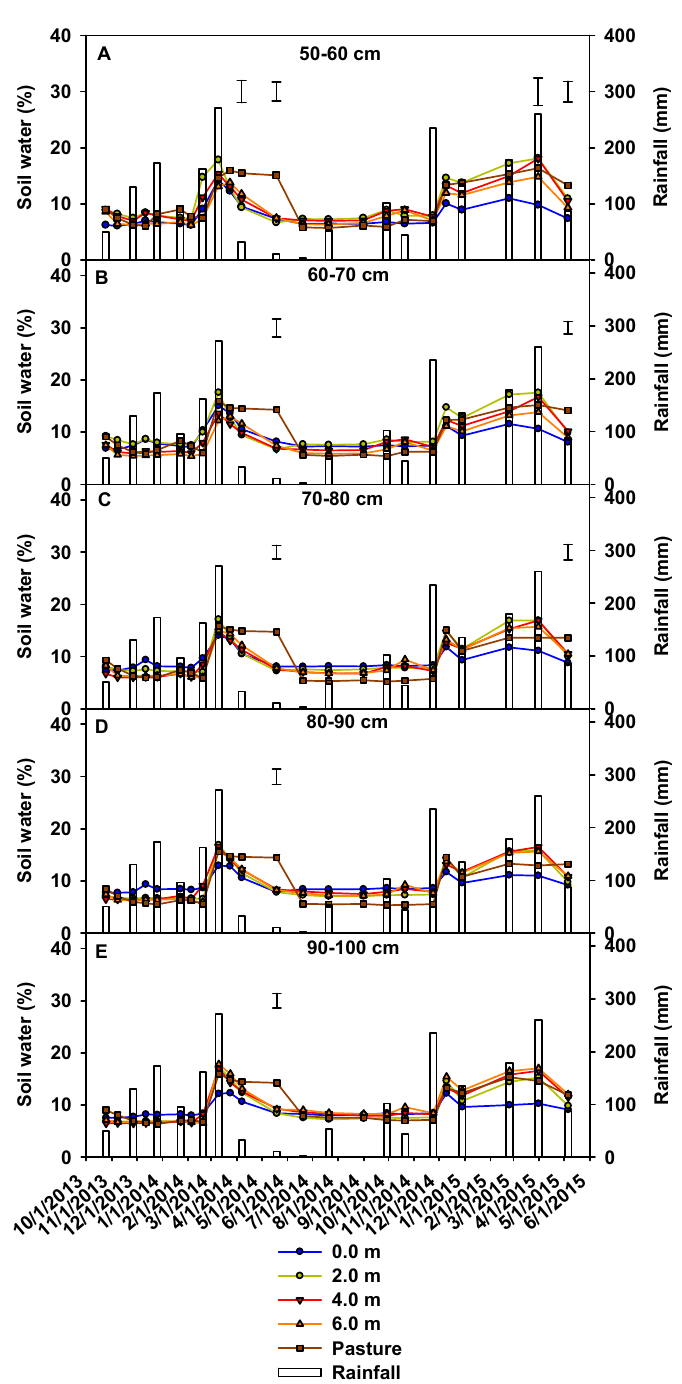
Figure 3. Average soil water content at soil depths of ( A ) 50–60 cm, ( B ) 60–70 cm, ( C ) 70–80 cm, ( D ) 80–90, and ( E ) 90–100 cm as a function of sampling location: 0.0 (planting row), 2.0, 4.0, and 6.0 m from the Eucalyptus tree rows and in monoculture pasture. Bars indicate LSD (0.05) values for dates with significant differences between sampling locations.